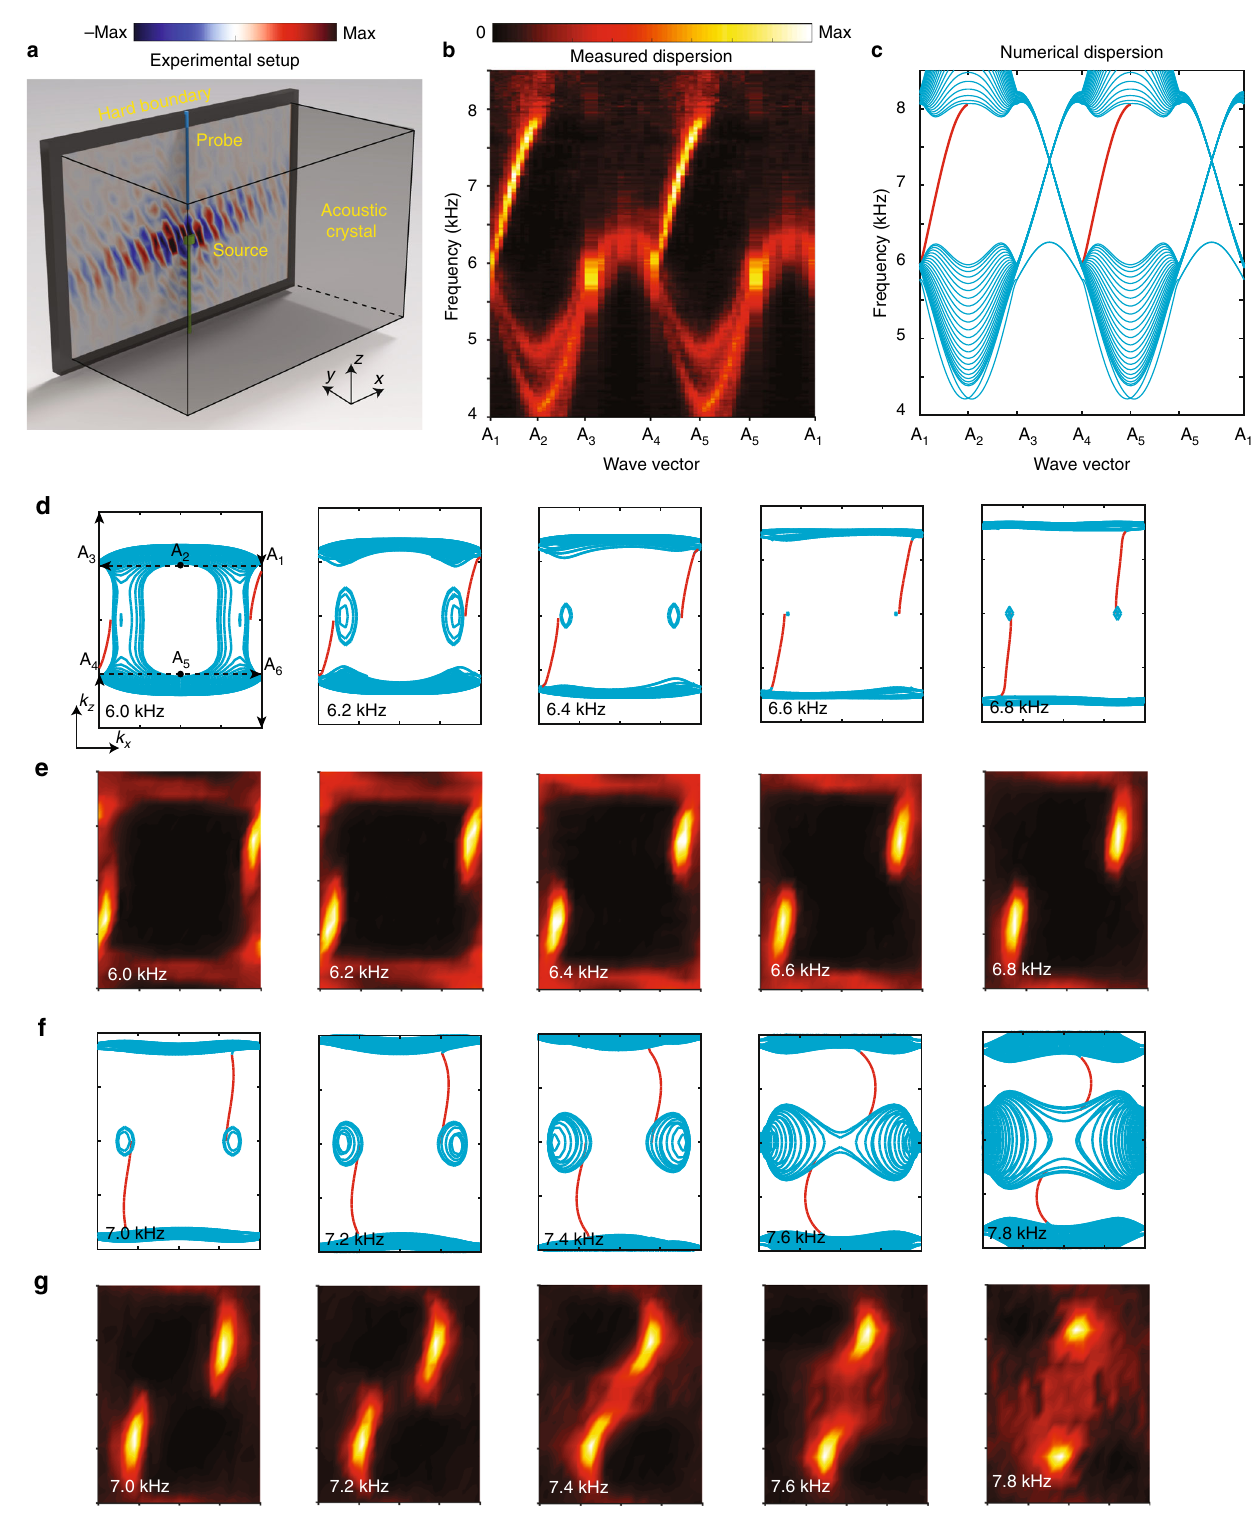
Fig. 3 Observation of surface-state arcs emanating from the topological nodal surface. a Experimental setup. The fi eld distributions are measured along a hard boundary between the acoustic crystal and acrylic board. b , c Measured and simulated surface dispersion along selected directions in the 2D plane, indicated by the points marked A 1 – A 6 in ( d ). Here, A 1 to A 6 represent the momentum points ( π / a , 0.5 π / h ), (0, 0.5 π / h ), ( − π / a , 0.5 π / h ), ( − π / a , − 0.5 π / h ), (0, − 0.5 π / h ), and ( π / a , − 0.5 π / h ), respectively. d , f Simulated isofrequency surfaces in the 2D momentum space, at speci fi c frequencies ranging from 6.0 – 7.8 kHz. e , g Measured in-plane energy densities for the same set of frequencies. For every subplot in ( d – g ), the horizontal axis ( k x ) runs over [- π / a , π / a ], and the vertical axis ( k z ) runs over [- π / h , π / h